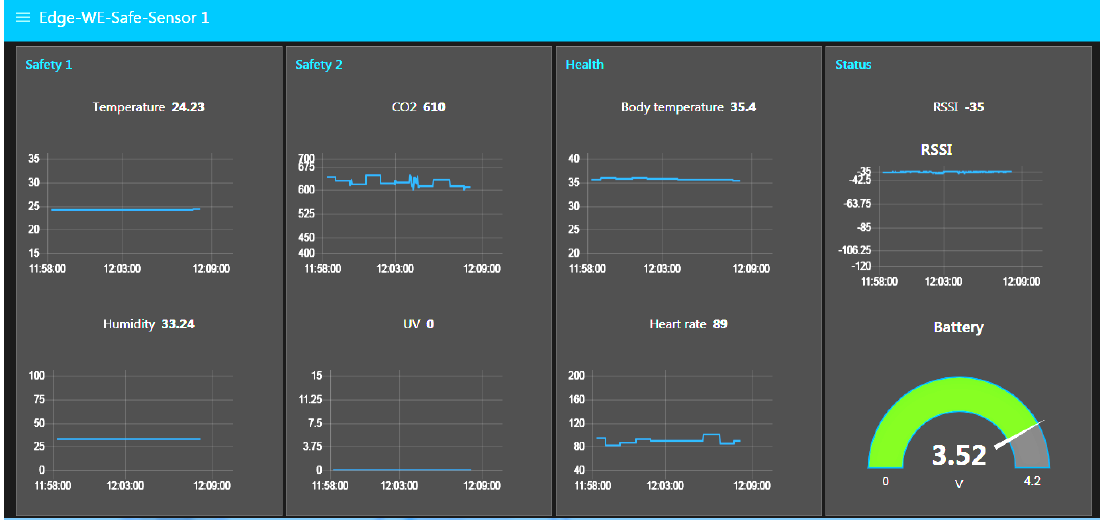
Figure 11. The website on the local IoT gateway.